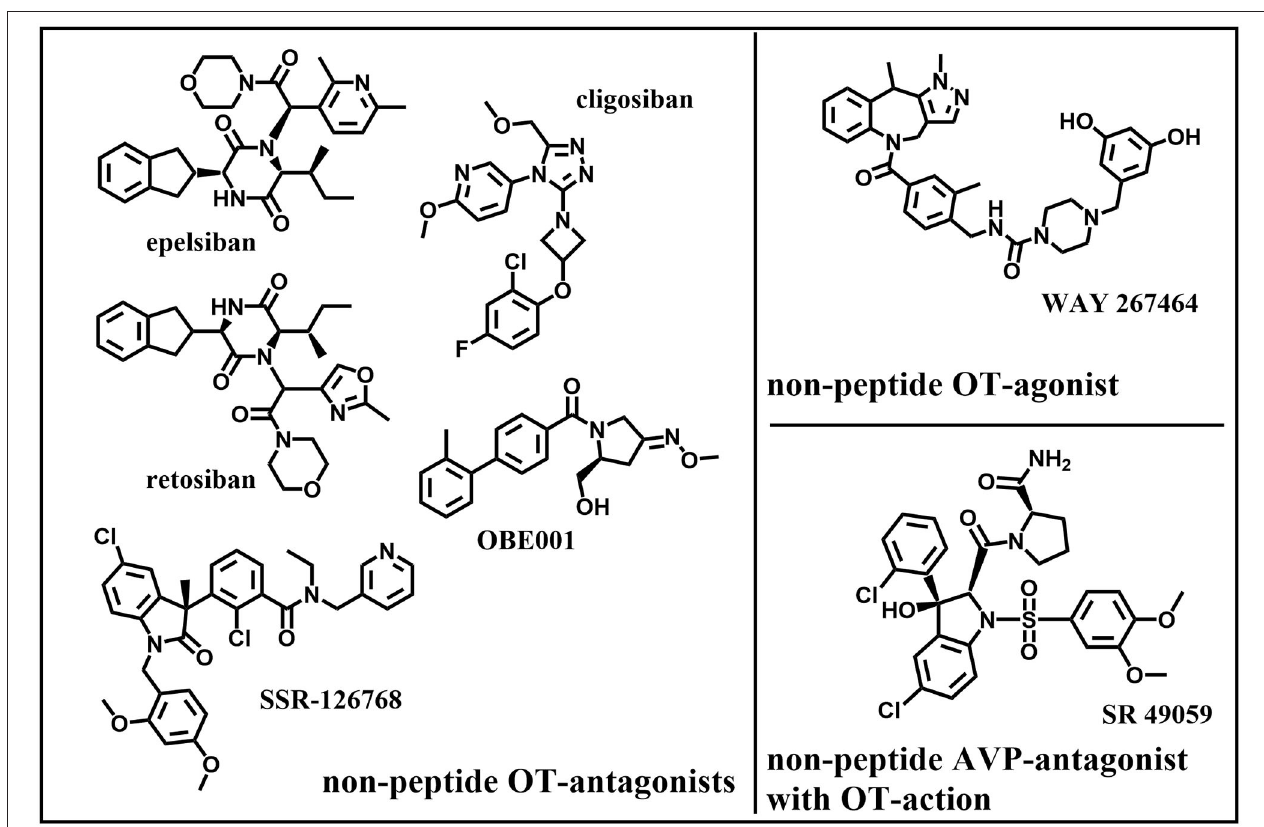
FIGURE 8 | Original: Chemical structures of five non-peptide OT-antagonists, one –agonist, and one non-peptide AVP-antagonist with OT-action.